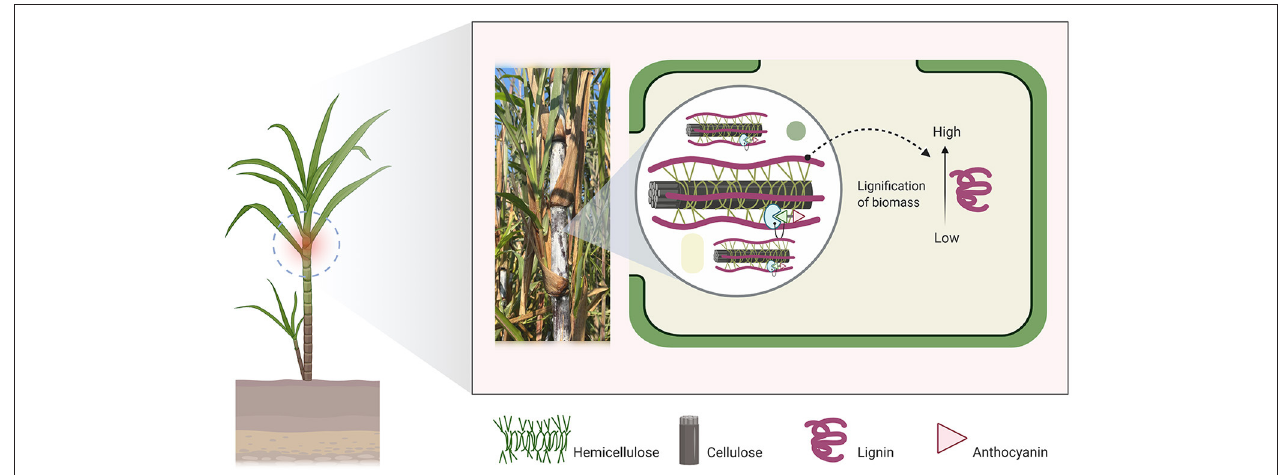
FIGURE 1 | Black cane (BC: Saccharum sinensis Robx .) is a fast-growing grass (Poaceae) endemic to mainland Southeast Asia. It is a viable ruminant feedstock owing to its high concentration of soluble carbohydrates and anthocyanins. However, it needs pretreatment prior to ensiling due to the high amount of lignocellulose agricultural